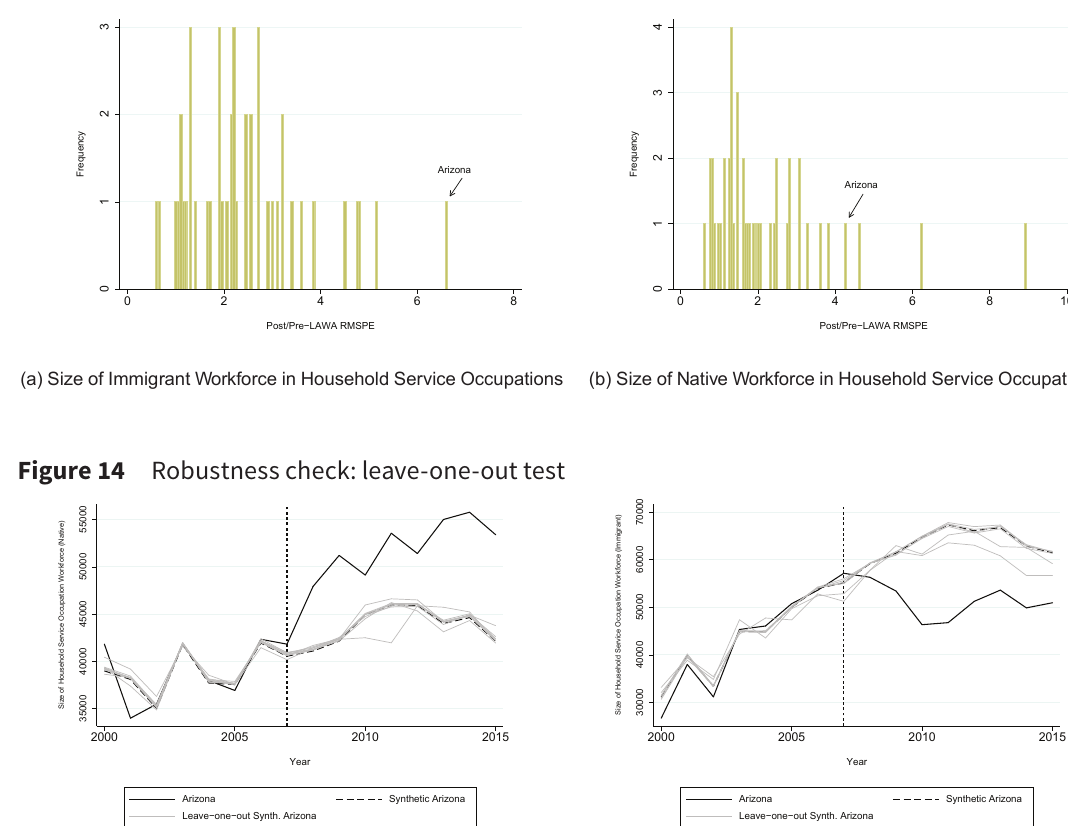
Robustness check: taking into account pre-treatment match quality